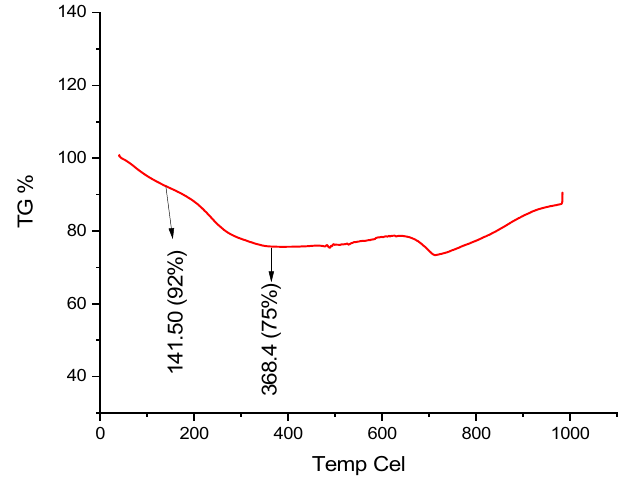
Figure 4. TGA curve of MWCNT/Ruthenium hydroxide aerogel.